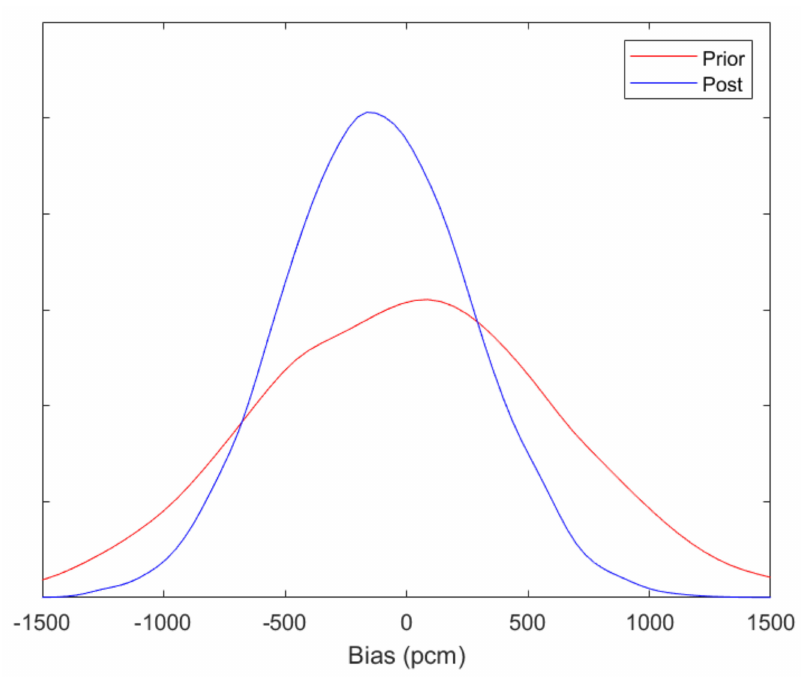
Figure 5. Application of prior- and post-TSURFER